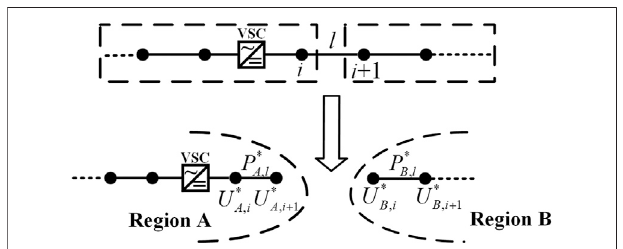
FIGURE 1 | Schematic diagram of partitioning